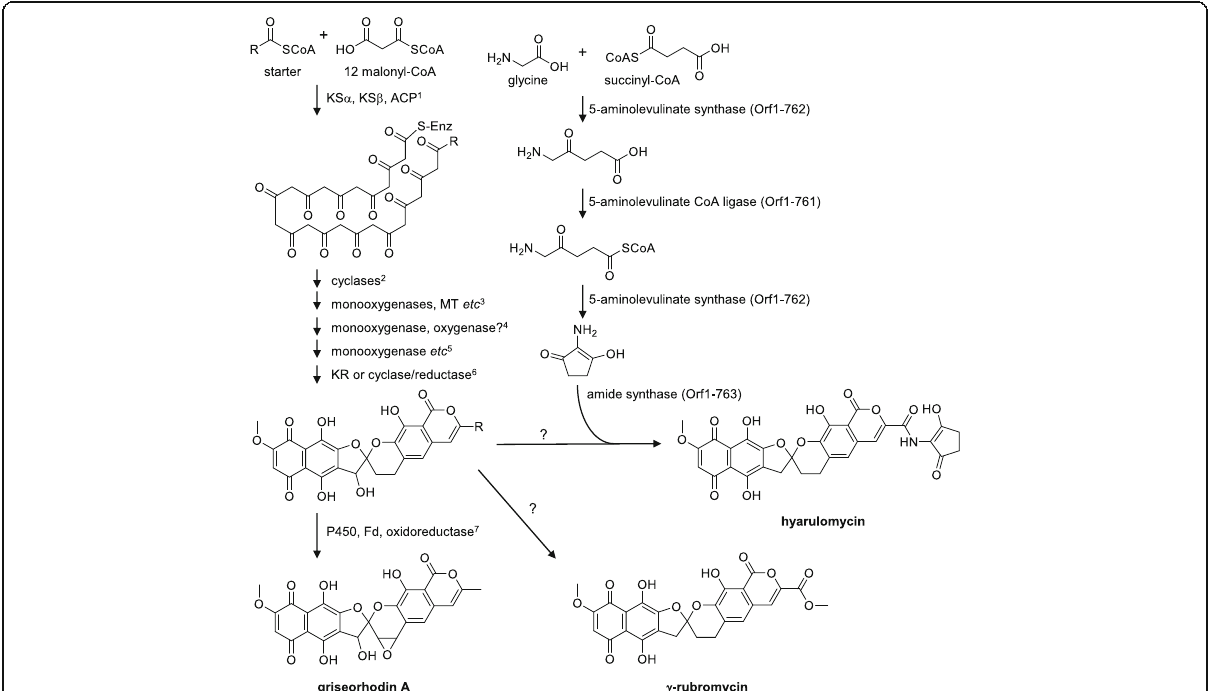
Fig. 4 Putative biosynthetic pathways of hyarulomycin, rubromycin and griseorhodin. Each step is catalyzed by enzymes encoded following genes as proposed in griseorhodin biosynthesis [4]. 1 grhA / rubA /orf1-742 (KS α ), grhB / rubB /orf1-741 (KS β ) and grhC / rubC /orf1-740 (ACP); 2 grhE / rubK ?/orf1-769?, grhQ / rubE /orf1-744, grhS / rubD /orf1-743 and grhT / rubF /orf1-739, 3 grhO8 / rubO /orf1-750, grhO9 / rubP /orf1-749 (monooxygenases), grhL / − /orf1-751 (MT), grhM / rubQ /orf1-748 (unknown) and grhP / rubR /orf1-746 (asparagine synthase); 4 grhO5 / rubL /orf1-755 (monooxygenase) and grhO1 / rubI /orf1-758 (oxygenase)?; 5 grhO6 / rubN /orf1-753 (monooxygenase) and grhJ / − /orf1-756 (acetyltransferase)?; 6 grhO10 / rubG /orf1-738 (KR) or grhT / rubF /orf1-739 (cyclase/reductase); 7 grhO3 / rubU /orf1-735 (cytochrome P450), grhO4 / − / − (ferredoxin) and grhO7 / − /orf1-752 (oxidoreductase). Homologs are connected with slashes in order of rubromycin/griseorhodin/hyarulomycin. ACP, acyl carrier protein; CLF, chain length factor; Fd, ferredoxin; KS, ketosynthase; KR, ketoreductase; MT, methyltransferase; − , no homolog in the